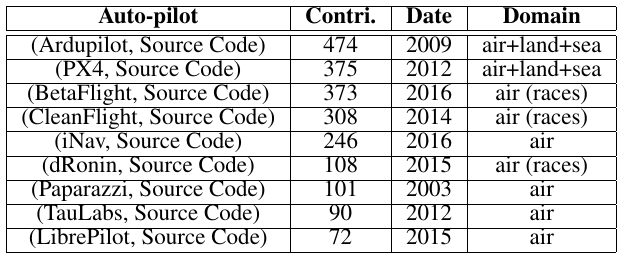
Table 1. Popular open-source autopilots ranked by number